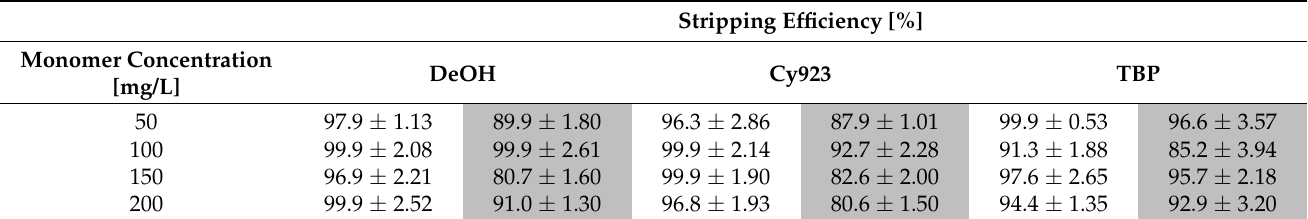
Figure 3. Effect of different monomer concentrations on the extraction yields of vanillin ( a ) and catechol ( b ). Table 4. Stripping efficiencies of vanillin and catechol using different monomer concentrations (the colored efficiencies correspond to